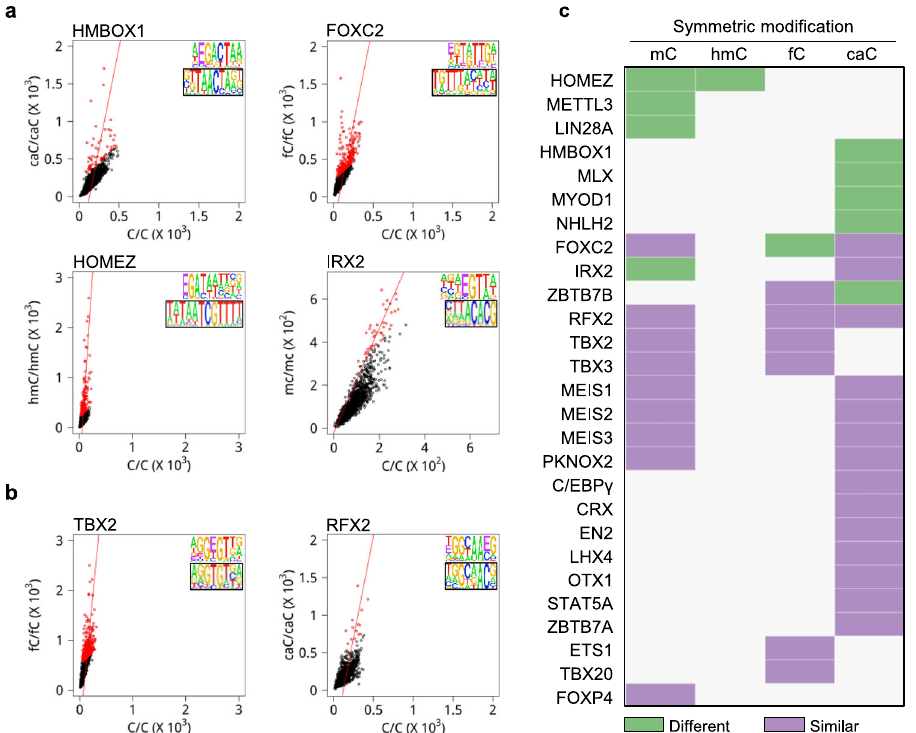
Fig. 5 Impact of symmetric epigenetic modi fi cations on TF-binding speci fi city. a Examples of deviated consensus sequences across all four epigenetic modi fi cations. Known consensus sequences (boxed) in the absence of any modi fi cations are compared with those carrying a modi fi ed cytosine. Letter E in the consensus sequences represents modi fi ed cytosine. b Examples (i.e., TBX2 and RFX2) of TF-binding speci fi city not affected by cytosine modi fi cations, although with enhanced binding af fi nity. c Summary of impact of different modi fi cations on TF-binding speci fi city. Green or purple bricks represent the consensus sequences generated from modi fi ed DNA libraries are different or similar with that from unmodi fi ed DNA libraries, respectively. Source data are provided as a Source Data fi